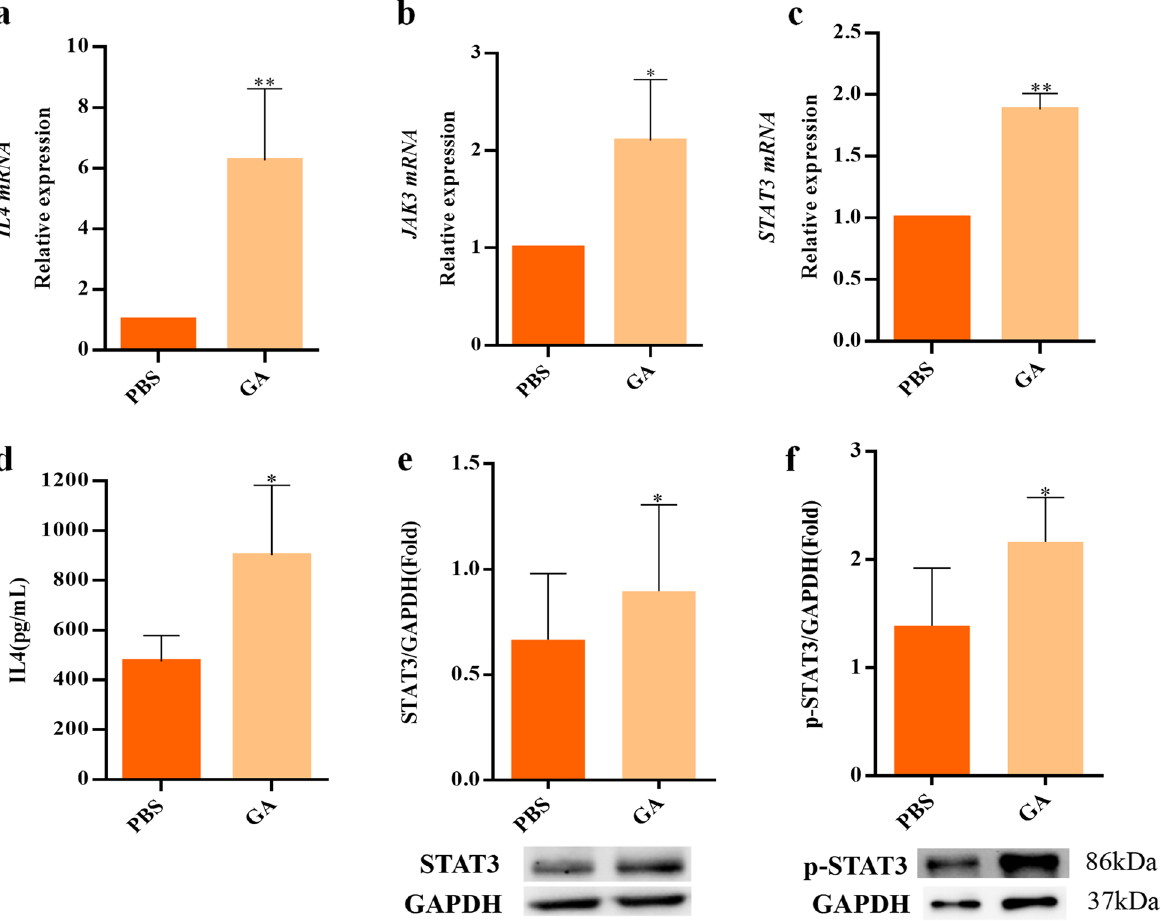
Fig. 5 Verification of the major differentially expressed genes and proteins in IL4/JAK3-STAT3 pathway. RT-qPCR results showed the increased expression levels of a IL4, b JAK3 and c STAT3 in GA (100 μM) group. d ELISA results showed the increased level of IL4 in GA (100 μM) group. Western blotting assay showed the increased levels of e STAT3 and f p-STAT3 in GA (100 μM) group. * P < 0.05; ** P < 0.01 ( n